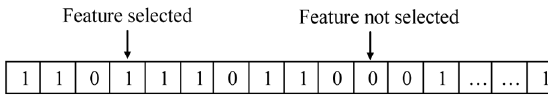
Fig. 1. Encoding of FSS